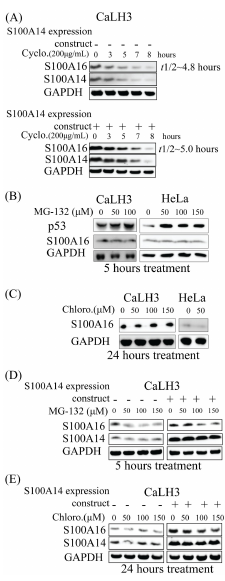
Figure 5. Both S100A16 and S100A14 proteins are degraded intracellularly by mechanism(s) other than proteasomal and lysosomal pathways. (A) Control and S100A14 over-expressing CaLH3 cells were treated with protein synthesis inhibitor cycloheximide in a time-course (0, 3, immunoblotted with anti-S100A16 and -S100A14